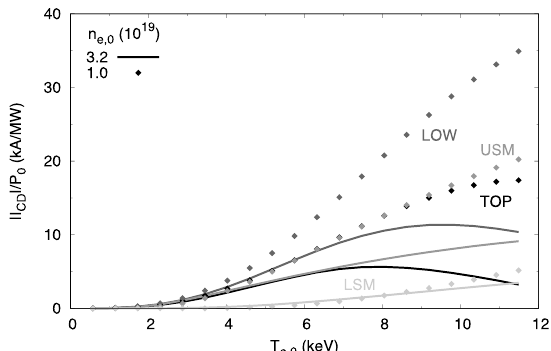
Fig. 8. Driven current as a function of T e,0 for different n e scaling (n e,0 in m -3 ).